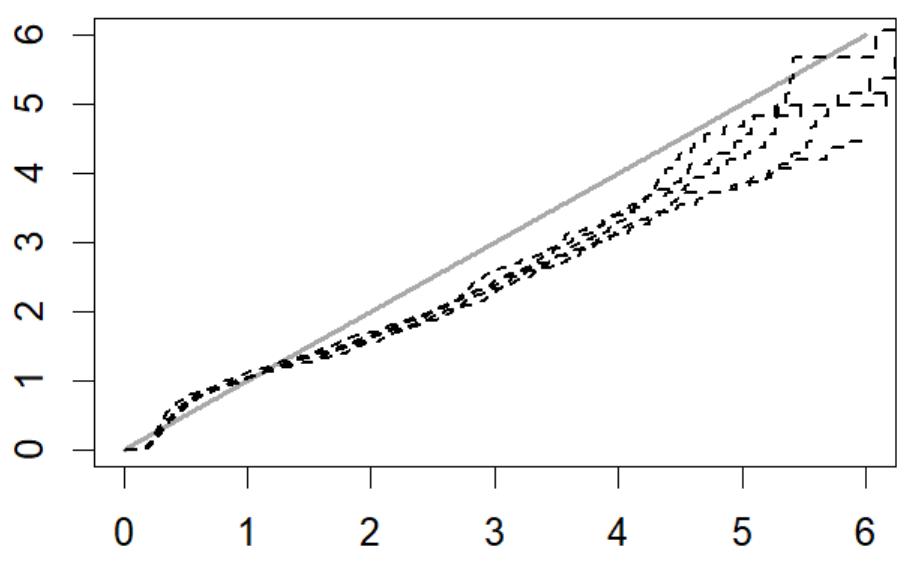
Figure 2. Cox–Snell plot.